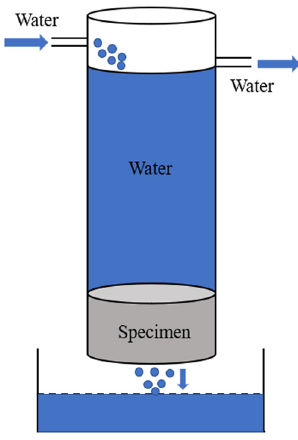
Figure 1: Water permeability resistance test.